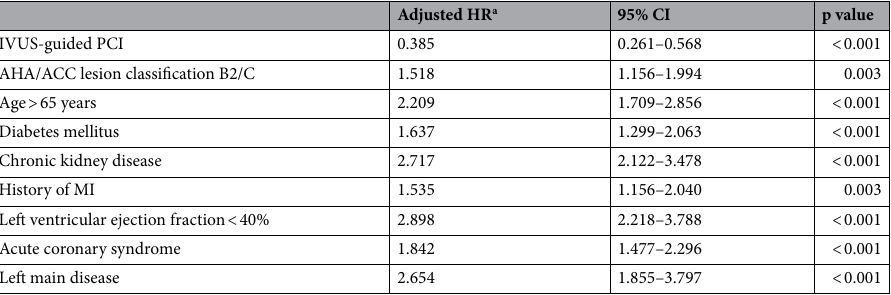
Table 4. Independent predictors of cardiac death or myocardial infarction after PCI. ACC, American College of Cardiology; AHA, American Heart Association; CI, confidence interval; HR, hazard ratio; IVUS, intravascular ultrasound; MACE, major adverse cardiac event; MI, myocardial infarction; PCI, percutaneous coronary intervention; TLR, target-lesion revascularization. a Adjusted variables were use of IVUS; age; sex; hypertension; diabetes mellitus; hyperlipidemia; chronic kidney disease; current smoker; previous history of PCI, MI, or cerebrovascular accident; left ventricular ejection fraction; acute coronary syndrome; multivessel disease; left main disease; lesion location; complex procedure; and medications (aspirin, P2Y12 inhibitor, statin, beta-blocker, and renin-angiotensin receptor